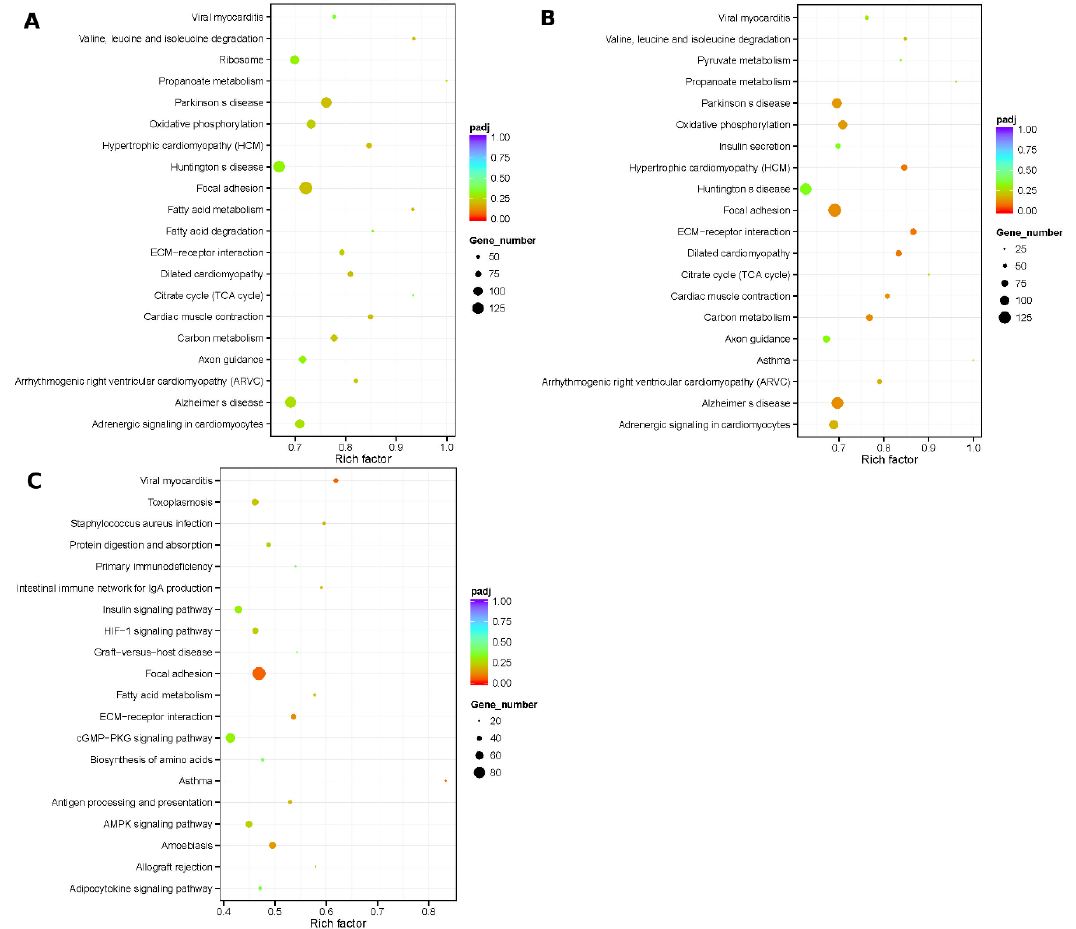
Figure 5. Top 20 of KEGG pathways enrichment for DEGs from three groups of pairwise comparisons. ( A ) Natal pigs vs. E65 pigs; ( B ) adult pigs vs. E65 pigs and ( C ) adult pigs vs. natal pigs. The x -axis presents a rich factor (rich factor = amount of DEGs enriched in the pathway/pathway/number of